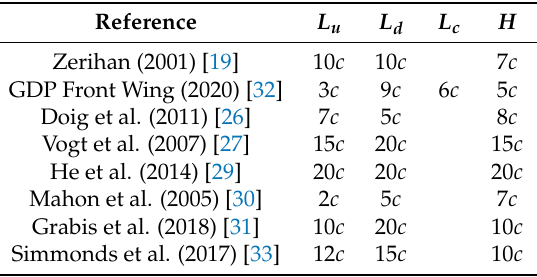
Figure 2. Domain used for numerical simulations. Table 1. Domain sizes found in the